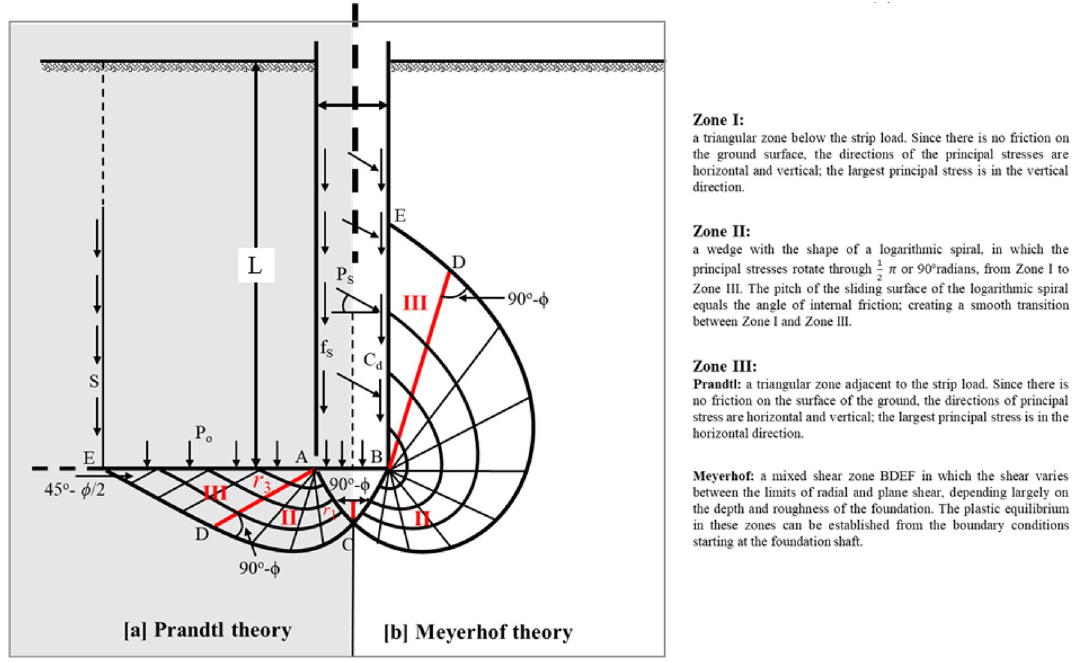
Figure 8. Plastic zones near the rough pile